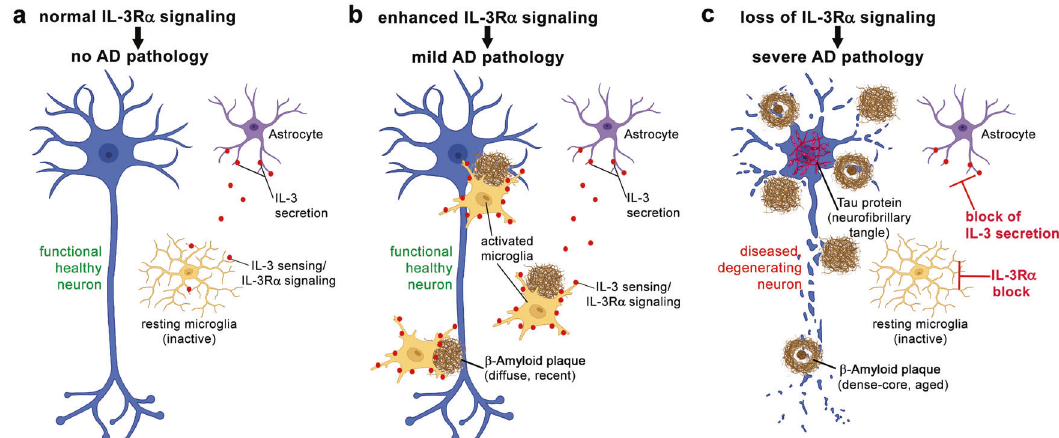
Fig. 1 Blocking of either astrocytic IL-3 secretion or microglial IL-3 sensing by IL-3R α results in worsened AD pathology in disease paradigms. a In conditions without typical AD pathology or stimuli, microglia are not triggered to become active. b In AD conditions, permissive IL-3/IL- 3R α signaling allows microglia to be transcriptionally reprogrammed and activated, which results in enhanced microglial motility and clustering of microglia around plaques, and as a likely consequence relatively mild AD pathology/plaque load. c Unphysiological, complete block of either astrocytic IL-3 secretion or microglial IL-3 sensing by IL-3R α both results in microglia that do not adequately respond to the presence of AD pathology, microglia remain quiescent, likely resulting in relatively severe AD pathology/plaque